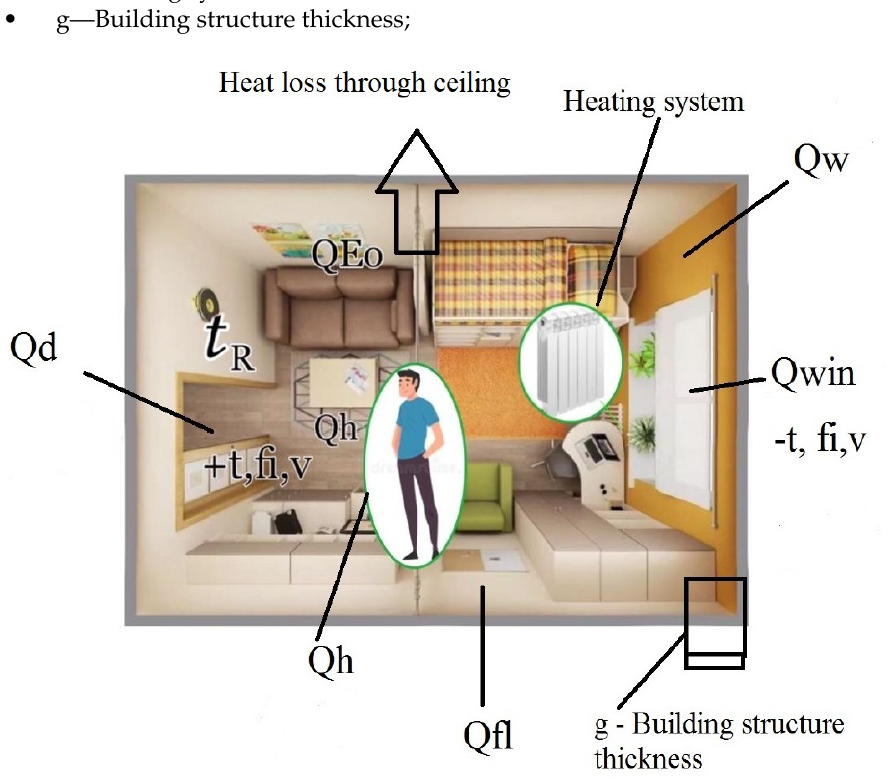
Figure 1. Room microclimate variables. Diagram based on